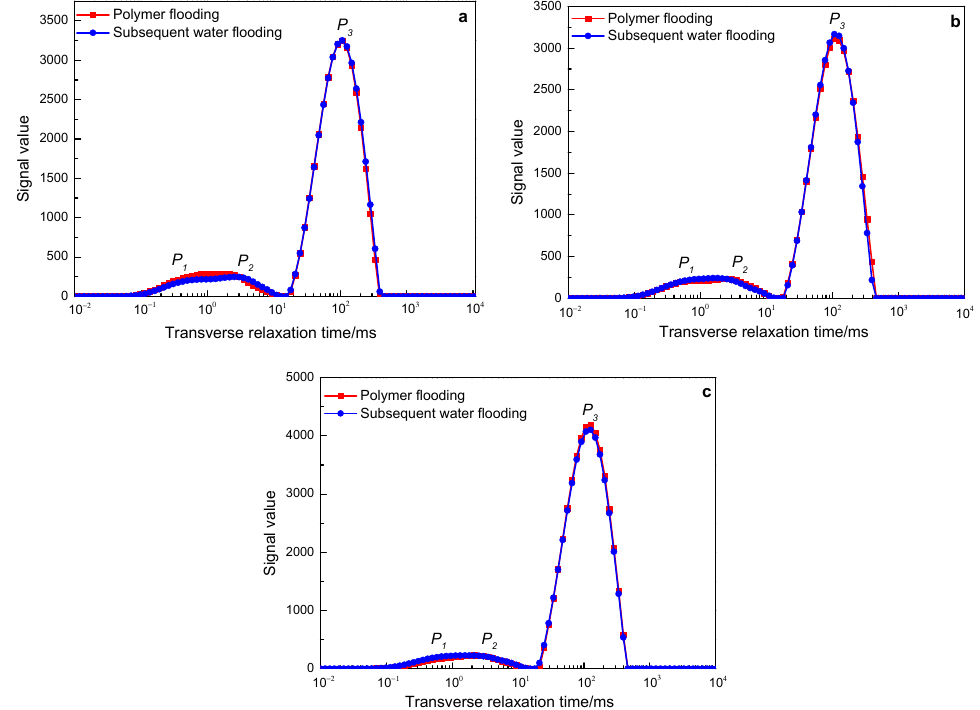
Figure 9. The change characteristics of the NMR T 2 spectrum curves of the polymer solution with a molecular weight of 16 million in rocks with different permeability after polymer flooding and subsequent water flooding: ( a ) 500 mD core; ( b ) 1000 mD core; ( c ) 2000 mD core.